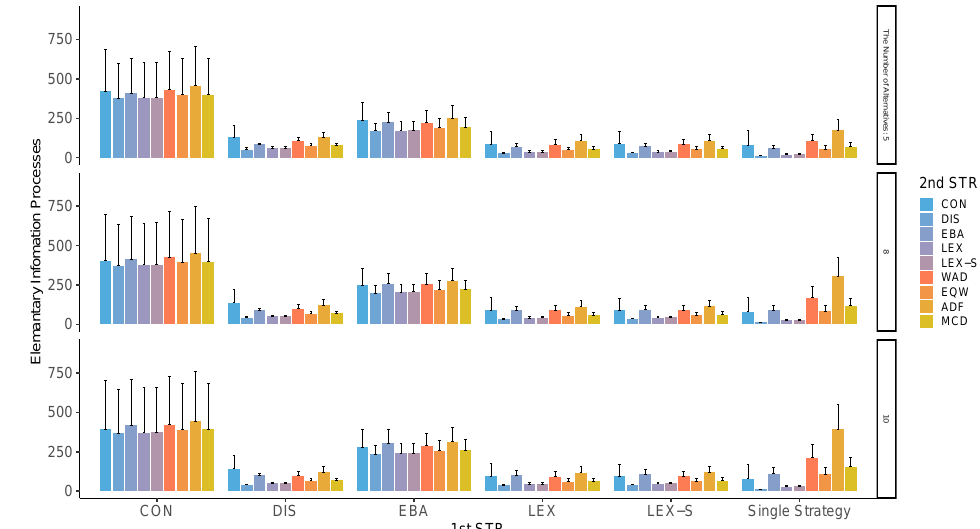
Figure A18. Average EIPs in two-stage decision-making when three alternatives are left in the second stage. Note: ADF: additive difference; CON: conjunctive; DIS: disjunctive; EBA: elimination by aspects; EQW: equal-weighted strategy; LEX: lexicographic; LEX-S: lexicographic semi-order; MCD: majority of confirming dimensions; STR: strategy; WAD: weighted